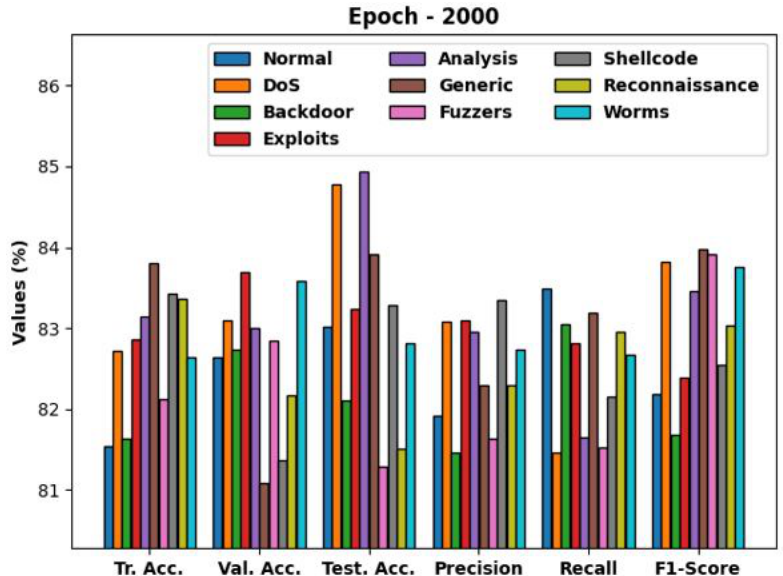
Figure 8. Result analysis of ESOML-IDS technique under 2000 epochs and distinct classes. Table 3. Result analysis of ESOML-IDS technique under 2000 epochs and distinct